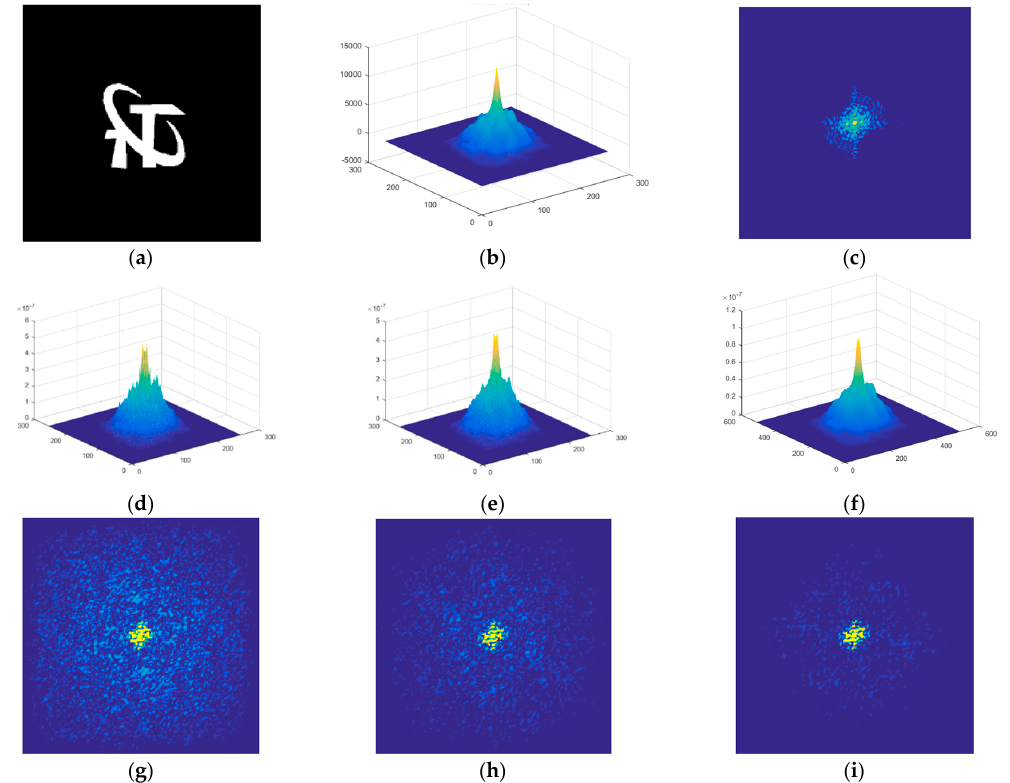
Figure 3. ( a ) Original image, ( b ) actual autocorrelation function of the original image, and ( c ) actual Fourier magnitude of the original image. ( d – f ) Estimated autocorrelation function of the original image from 200, 500, and 1000 speckle patterns, respectively. ( g – i ) Estimated Fourier magnitude of the original image from 200, 500, and 1000 speckle patterns, respectively.